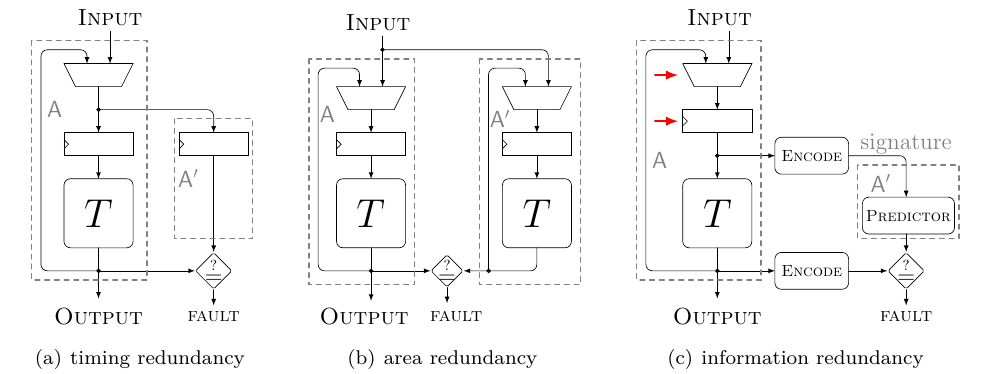
Figure 1: Common CED